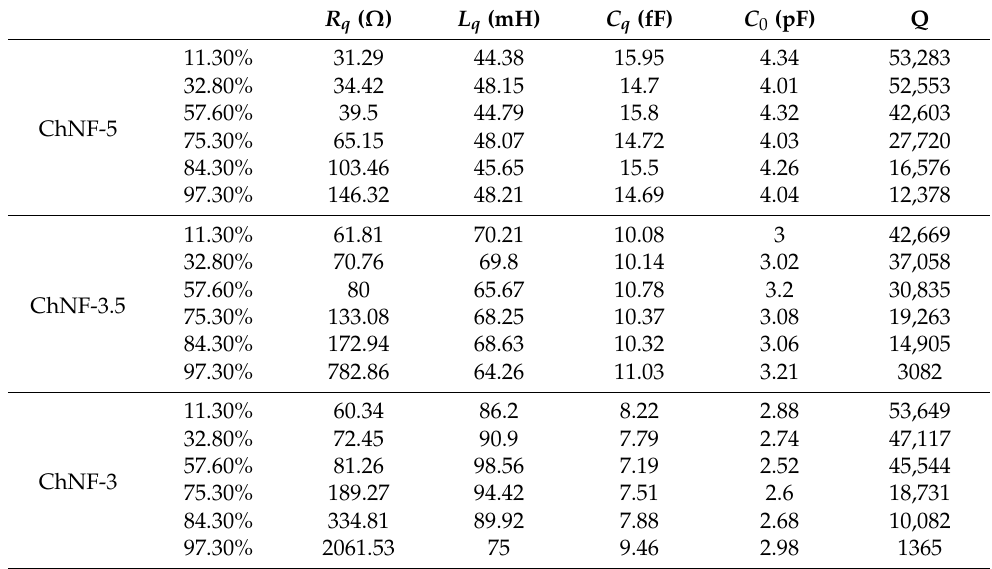
Table 2. The equivalent circuit parameters of ChNF-5, ChNF-3.5, and ChNF-3 at each humidity